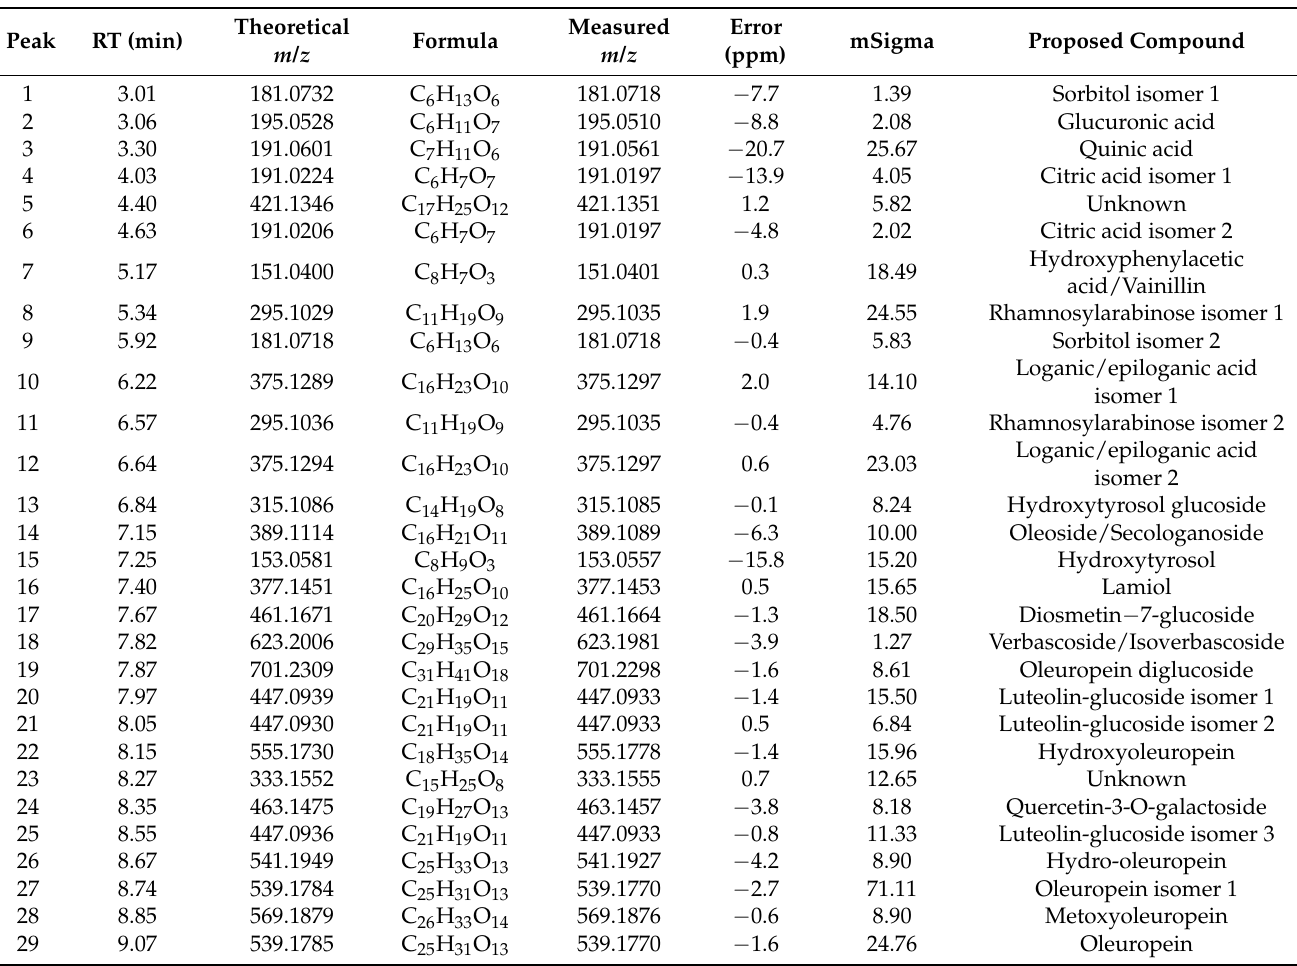
Table 1. Identified compounds in olive leaf extract.